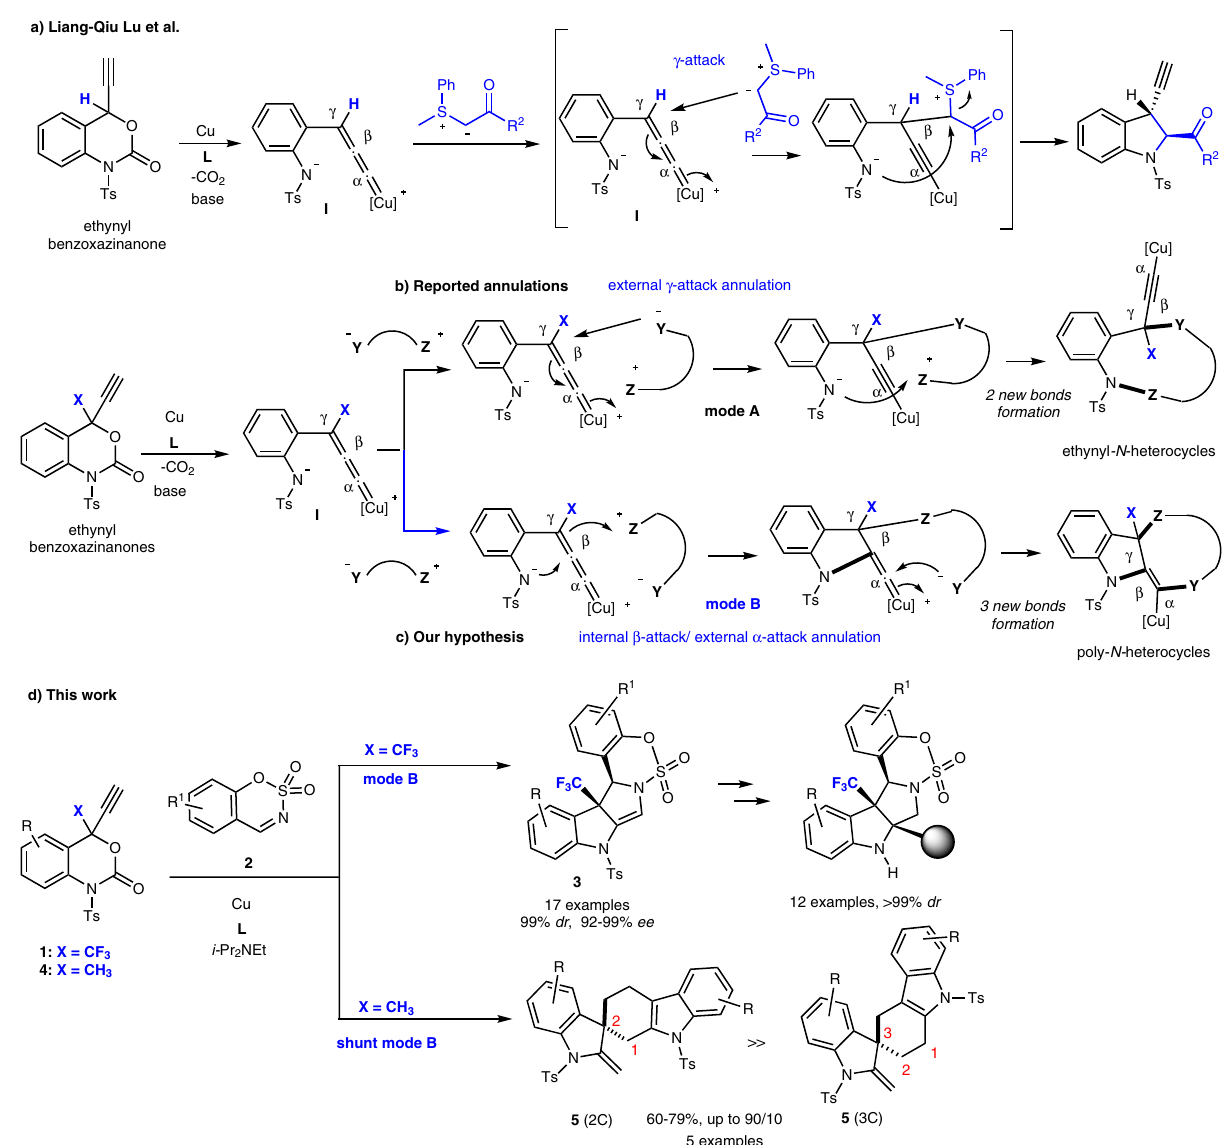
Fig. 2 Cu-catalyzed decarboxylative annulation of ethynyl benzoxazinanone. a The seminal work demonstrating the Cu-catalyzed decarboxylative [4 + 1] annulation of ethynyl benzoxazinanone with sulfur ylides. b A representative annulation mechanism of ethynyl benzoxazinanones with an interceptor (Y − ― Z + ) using Cu-catalysis (mode A). c Our hypothesis for a different annulation mode (mode B). d This work: annulation reactions of ethynyl benzoxazinanones ( 1 : X = CF 3 ; 4 : X = CH 3 ) that provide pentacyclic-fused CF 3 -indolines 3 via mode B , and non- fl uorinated spiral pentacyclic carbazole/indoline molecules 5 via shunt mode B